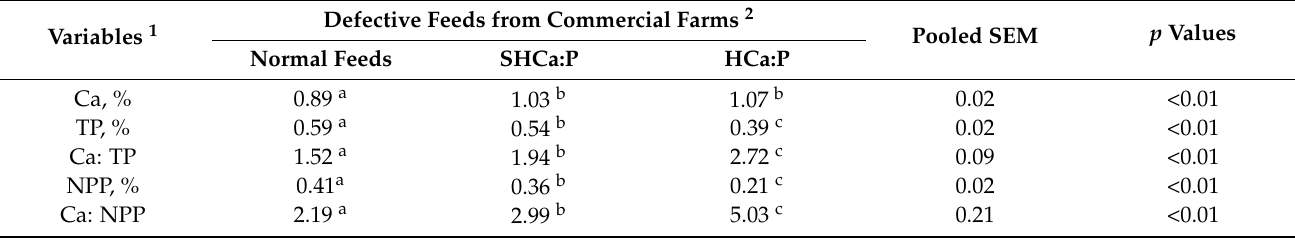
Table 3. Calcium (Ca), phosphorus (P) levels and Ca:P ratios in commercial feeds from field research (air-dry